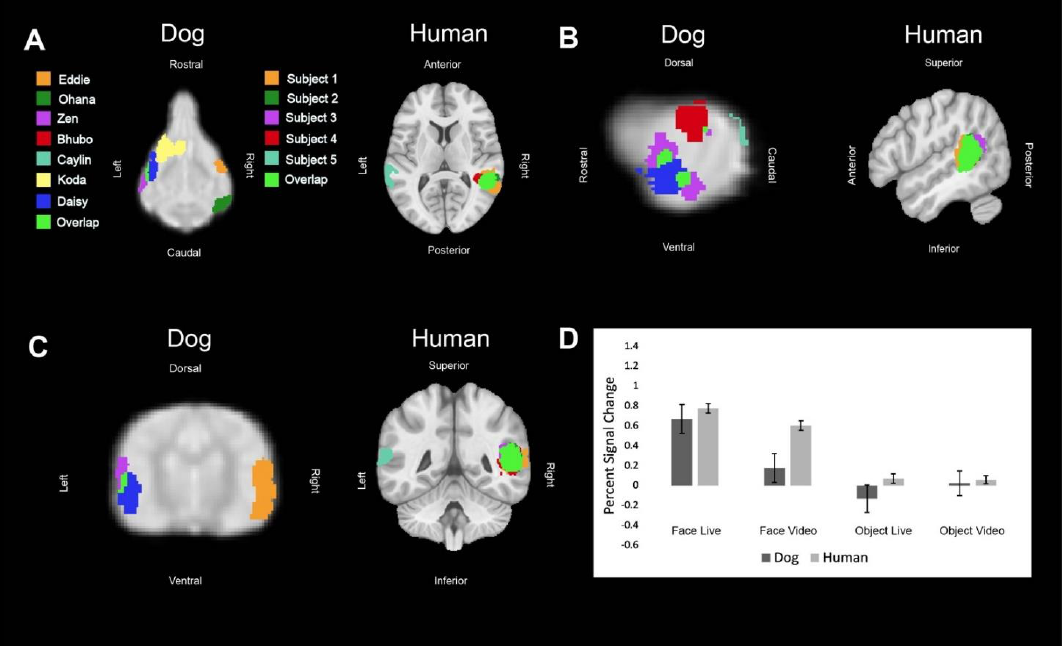
Figure 3. Definition and activations within the human posterior superior temporal sulcus and its analog in dogs. Each color represents the ROI of one dog or human or an area where the regions of interest overlapped. ( A ) Dorsal (dog) and axial (human) views of individual ROIs. ( B ) Sagittal views. ( C ) Transverse (dog) and coronal (human) views. ( D ) The bar graph shows the average percent signal change for each species for each condition relative to the implicit baseline. Error bars are the standard error.